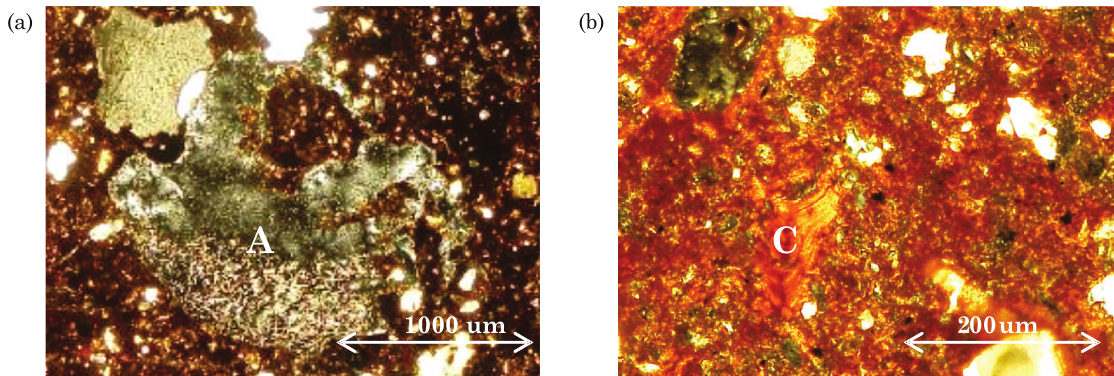
Figura 3. Fotomicrografias em luz polarizada cruzada (XPL) do P2. a) Preenchimento solto descontínuo de poro por calcita acicular (A), no horizonte Ap. b) Revestimento crescente de argila iluvial (C), no horizonte